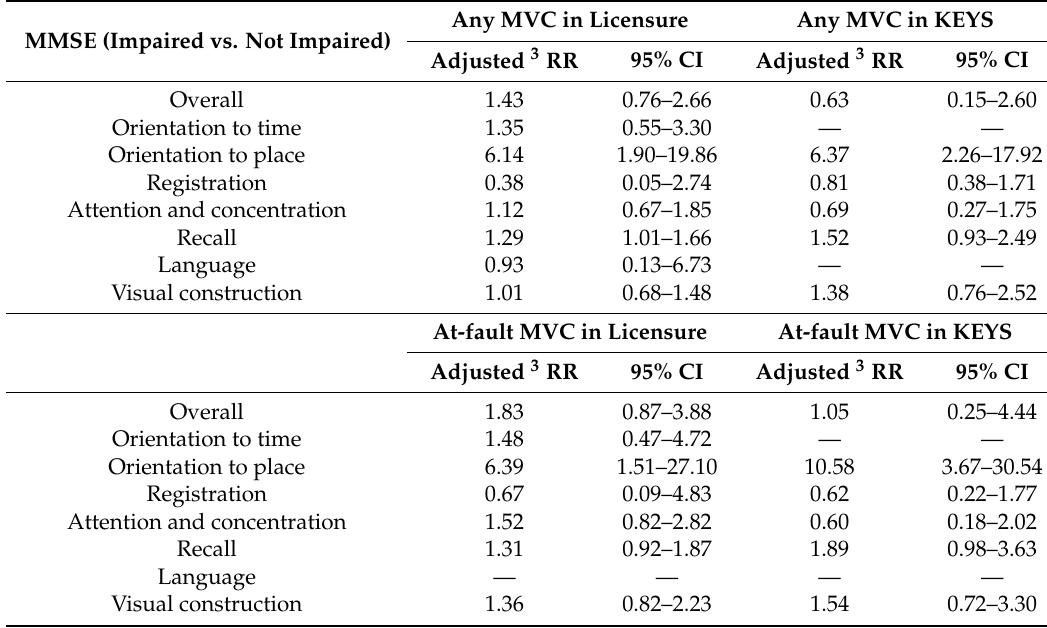
Table 2. Adjusted association between impairment on the MMSE domains at baseline and rate of future MVC